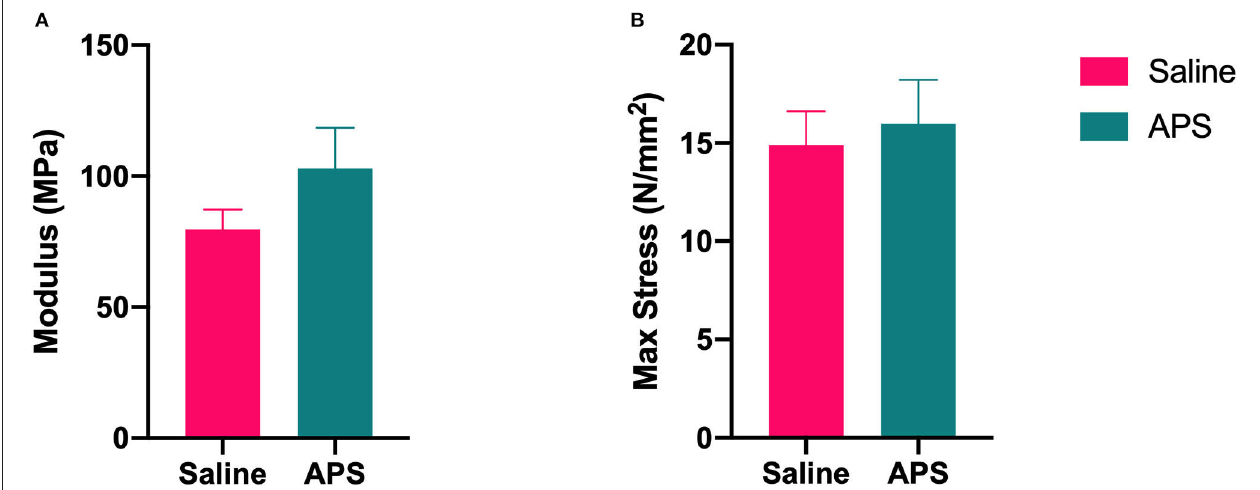
TABLE 1 | Mean scores ( ± SEM) of individual parameters for tenocyte shape, tenocyte density, hemorrhage, neovascularization, inflammatory cell infiltrates, collagen fiber linearity, collagen fiber uniformity, polarized light crimping, and epitenon thickening for normal tendons, saline treated tendons, and APS treated tendons. Epitenon Total score Polarized Collagen Collagen Tendon cell Tendon cell Free hemo- Neo- Inflam- thickening collagen fiber fiber shape density rrhage vasculature matory cell fiber crimp uniformity linearity infiltrate Normal 1.63 ( ± 0.17)